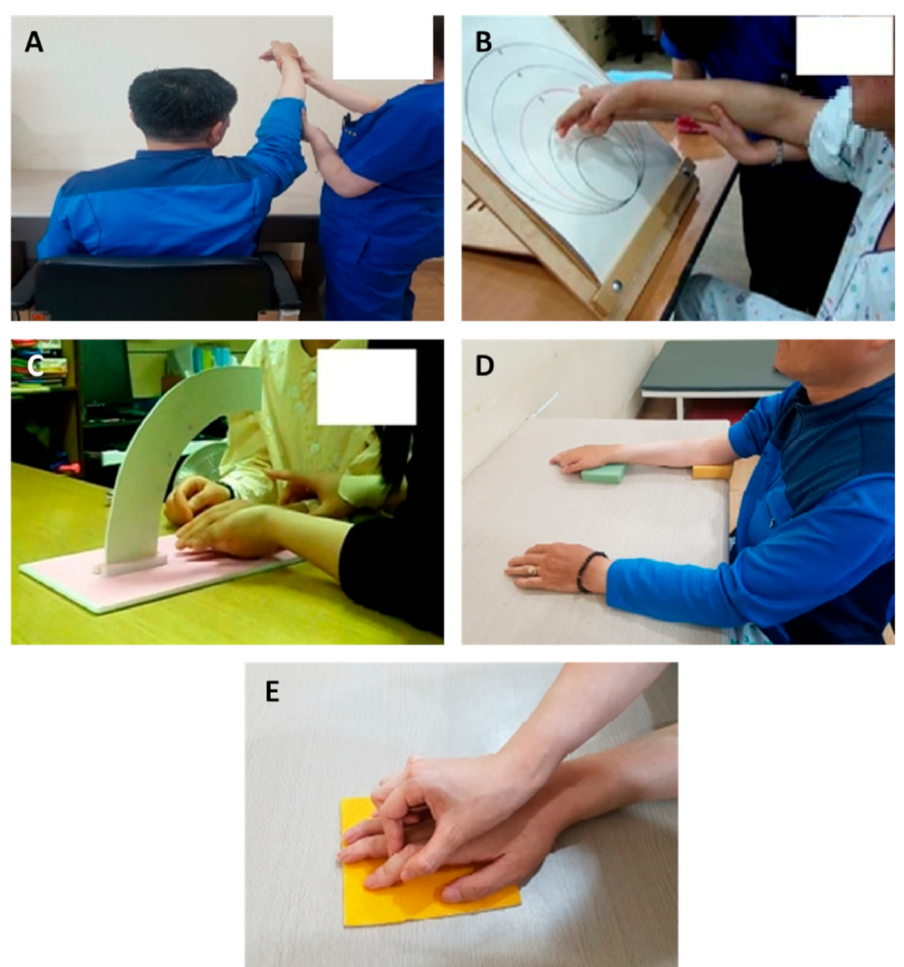
Figure 2. ( A ) Shoulder joint recognition training by motor imagery. ( B ) Shoulder and elbow joint recognition training using a circular track plate. ( C ) Training on awareness of elbow and wrist joint angles using a Bogen. ( D ) Training on pressure awareness of the elbow and wrist using a sponge. ( E ) Finger tactile recognition training using a tactile